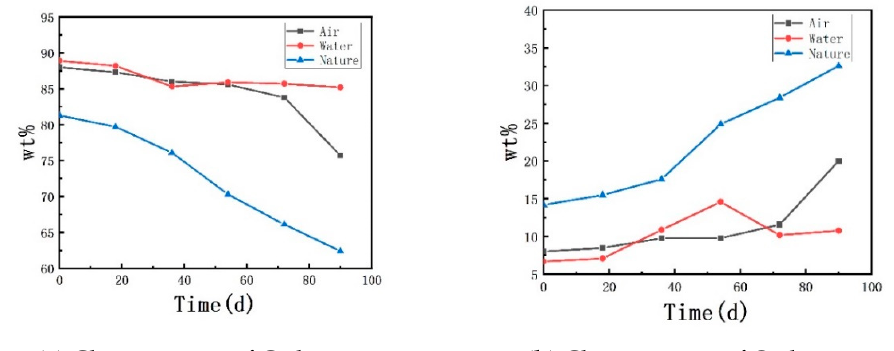
Figure 9. Change curve of element content.